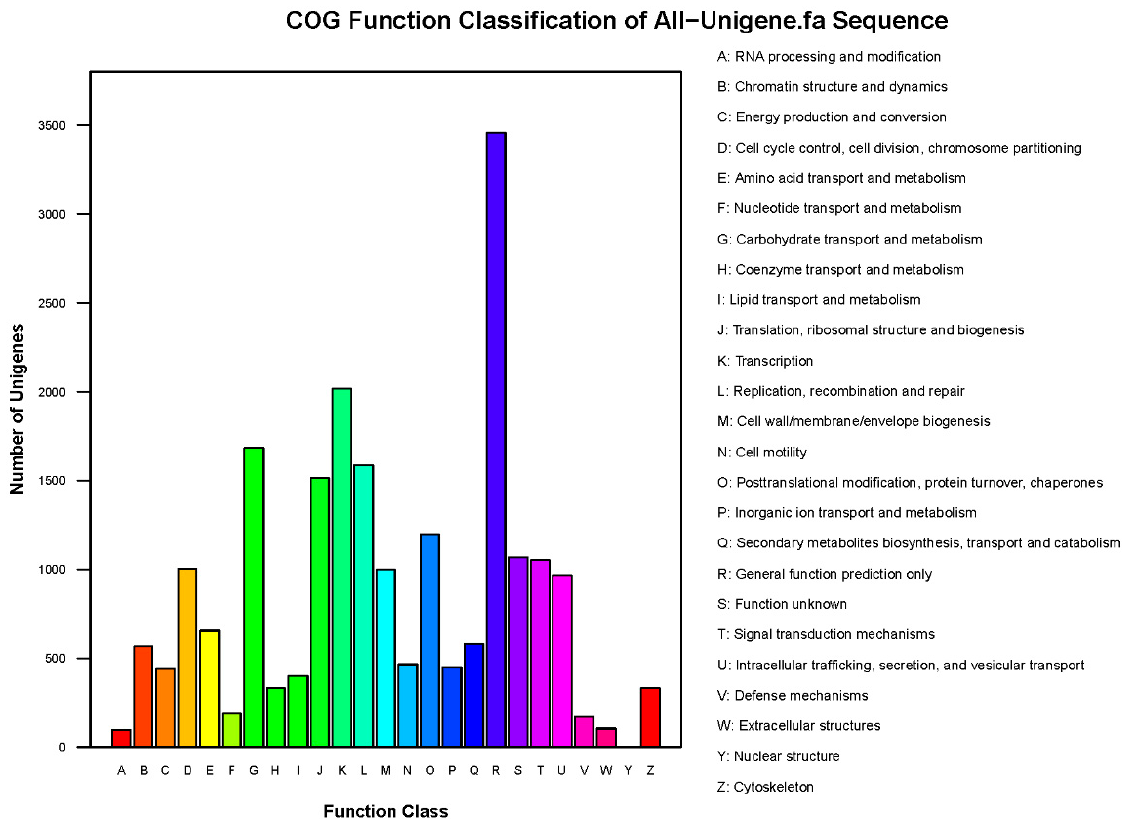
Figure 2. Classification of the clusters of orthologous groups (COG) for the transcriptome.